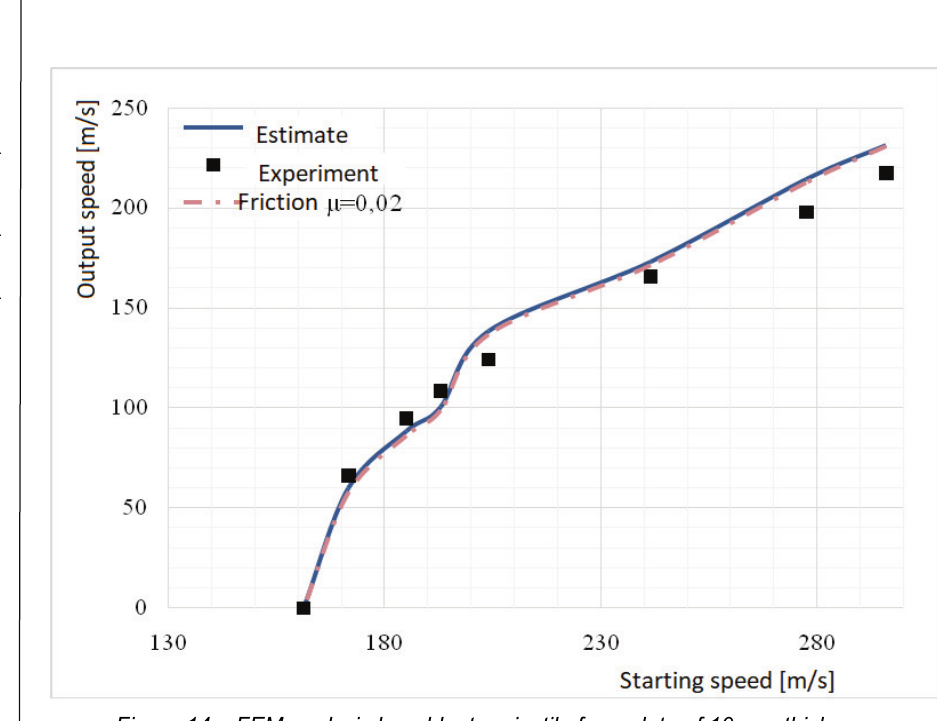
Figure 14 – FEM analysis by a blunt projectile for a plate of 10 mm thickness Рис . 14 – Анализ F Е M тупоконечным снарядом на плиту , толщиной 10 мм